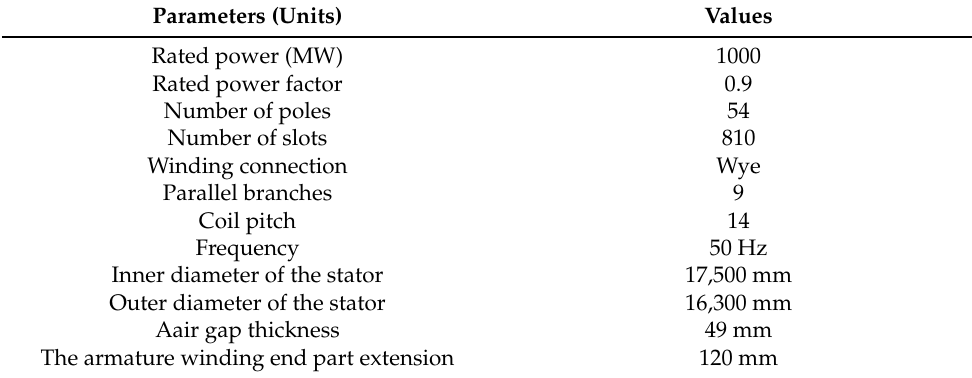
Table 1. Basic parameters of the hydropower